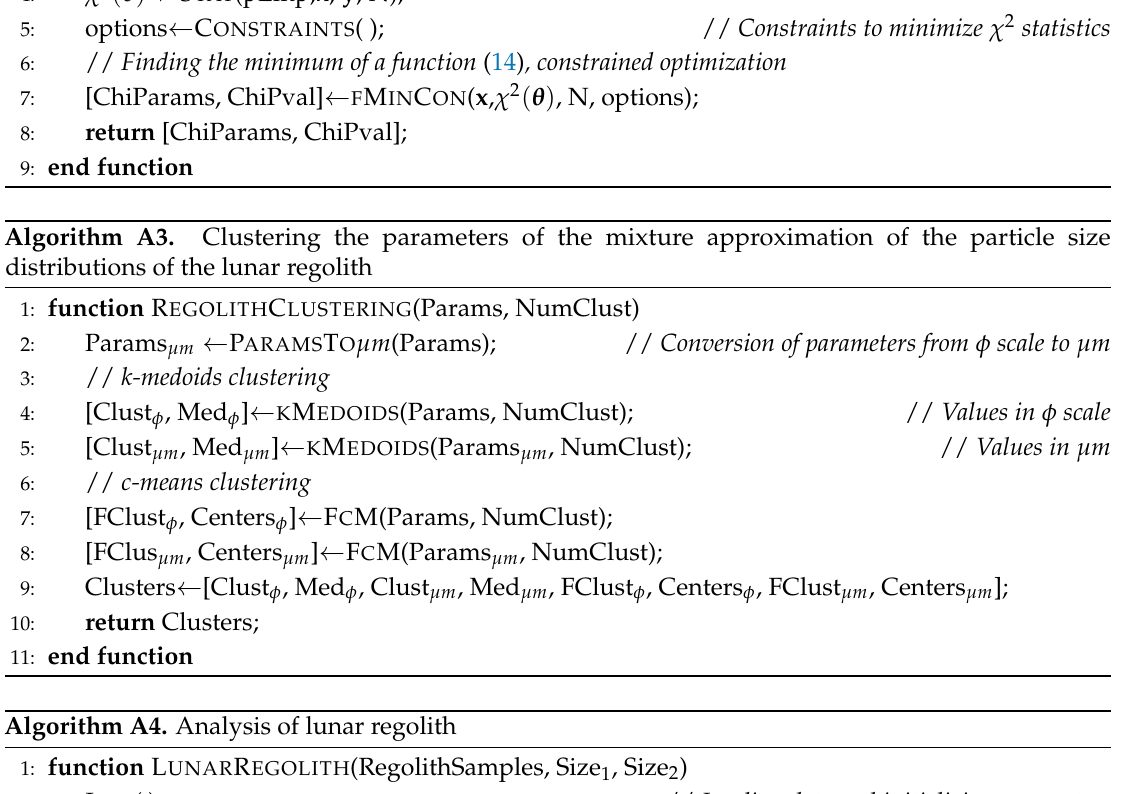
Algorithm A4. Analysis of lunar